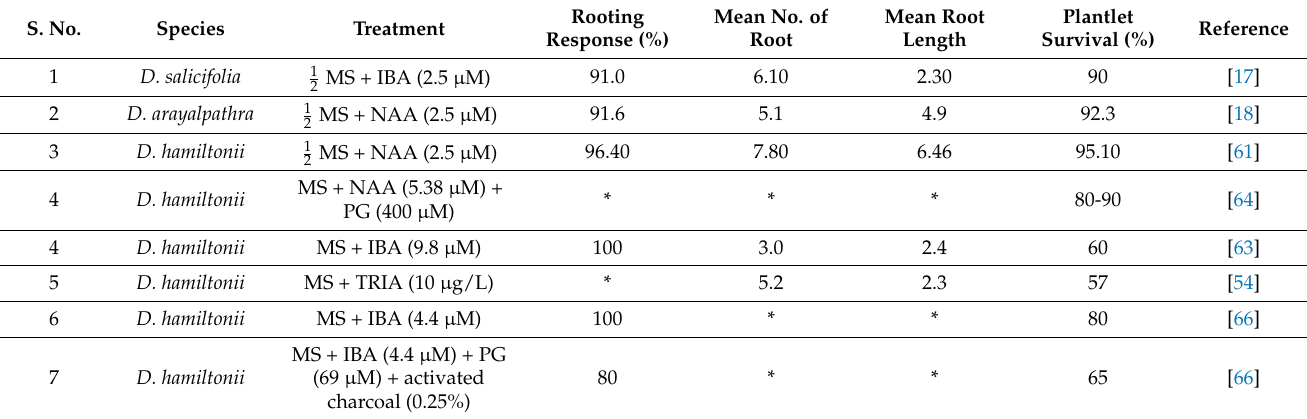
Table 3. In vitro root regeneration from the obtained shoot in species from the genus Decalepis